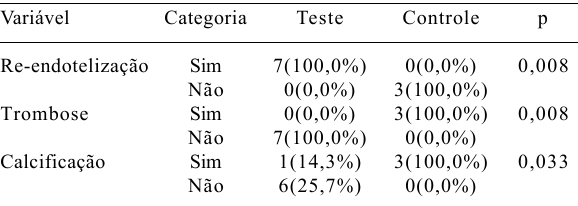
Tabela 2. Freqüências absolutas e relativas dos achados histológicos após 150 dias do implante valvular.